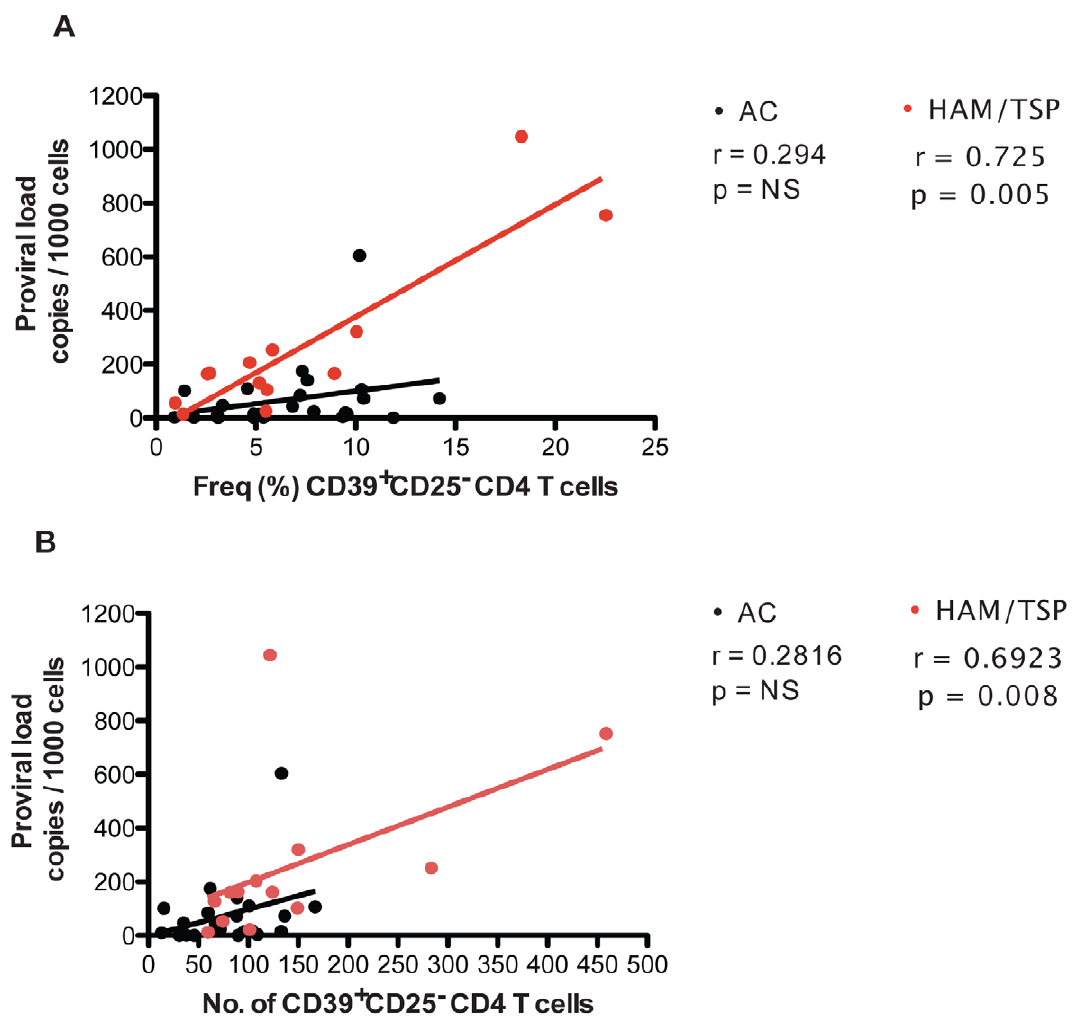
Figure 3. Association between HTLV-1 proviral load and CD39 + CD25 2 CD4 + T cells in HAM/TSP patients. Frequency of CD39 + CD25 2 CD4 + T cells (A) and number of CD39 + CD25 2 CD4 + T cells (B) were plotted against proviral load of AC and HAM/TSP patients. The statistical difference was deemed significant using a two-tailed Spearman test analysis if p , 0.05.